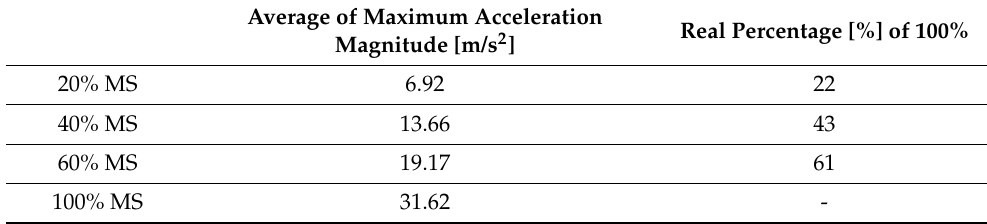
Table 2. Average of maximum acceleration magnitude of every cycle with the same MS parameter. Average of Maximum